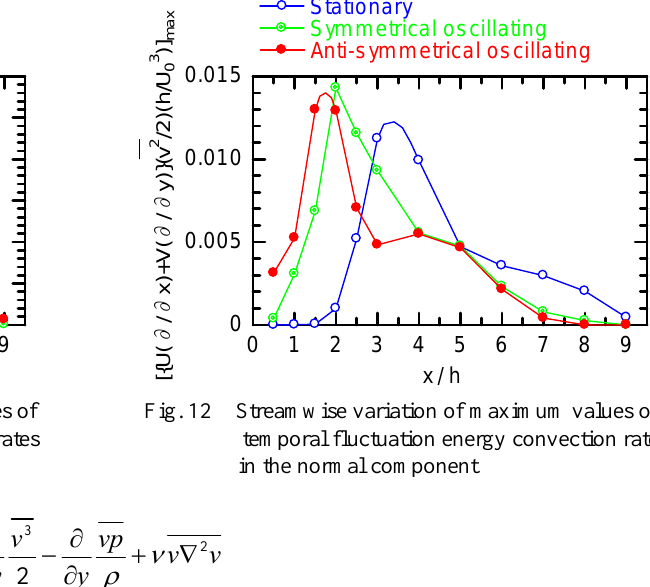
Fig. 11 Streamwise variation of maximum values of Fig. 12 Streamwise variation of maximum values of temporal fluctuation energy convection rates temporal fluctuation energy convection rates in the streamwise component in the normal